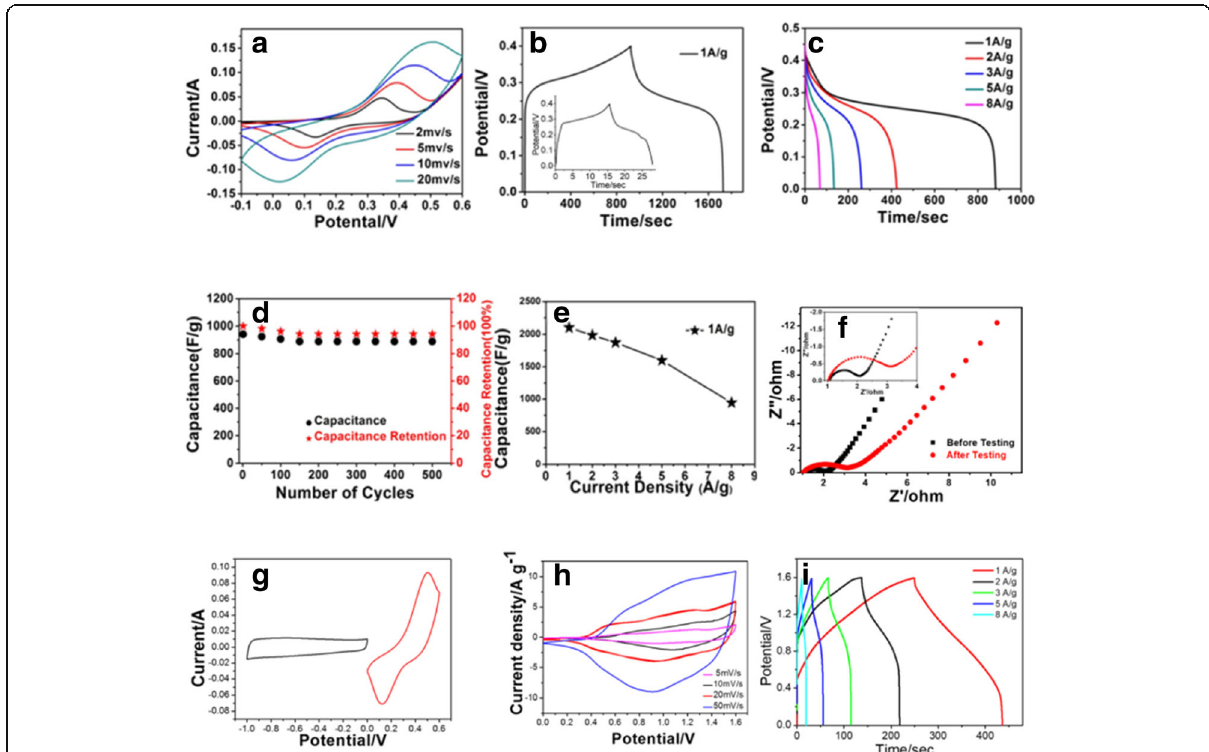
Fig. 6 a CV curves of Co-Cl(NiE) at various scan rates. b Galvanostatic charge and discharge curve of Co-ClNWs(NiE) at 1 A/g (inset: GCD curve of nickel foam with the same current of Co-ClNWs(NiE) at 1A/g). c GCD curves of Co-ClNWs(NiE) at various current densities. d Long cyclic performance and capacitance retention of Co-ClNWs(NiE) at current densities of 8 A/g. e Average specific capacitance at various discharge current densities. f EIS spectra of Co-ClNWs(NiE) before and after electrochemical test over the frequency range from 100 kHz to 10 mHz. g CV curves of Co-ClNWs(NiE) and AC at a scan rate of 20 mV/s. h CV curves of the as-fabricated Co-ClNWs(NiE)//AC ASC device at various scan rates and the corresponding GCD curves ( i ) with different current